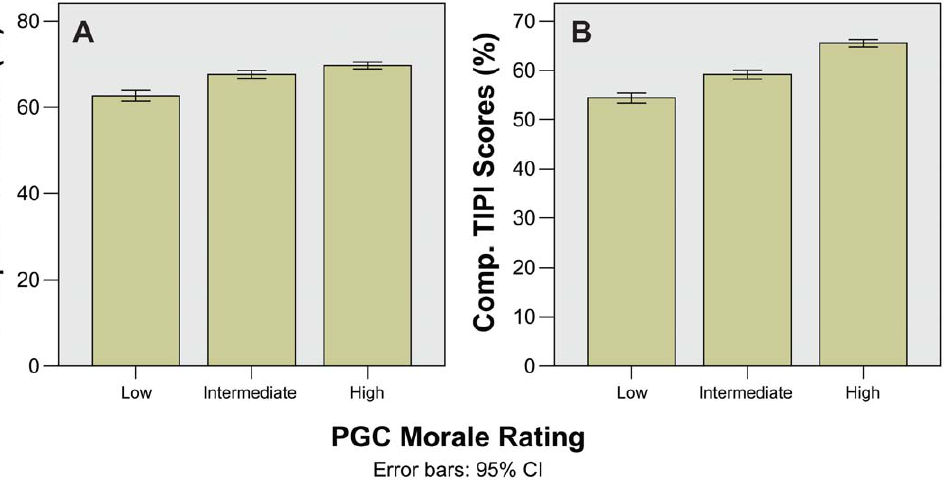
Figure 5. Bar charts showing composite Religiosity and Personality scores against PGC morale rating. A) I/E-R Religiosity, and B) TIPI Personality mean composite scores.